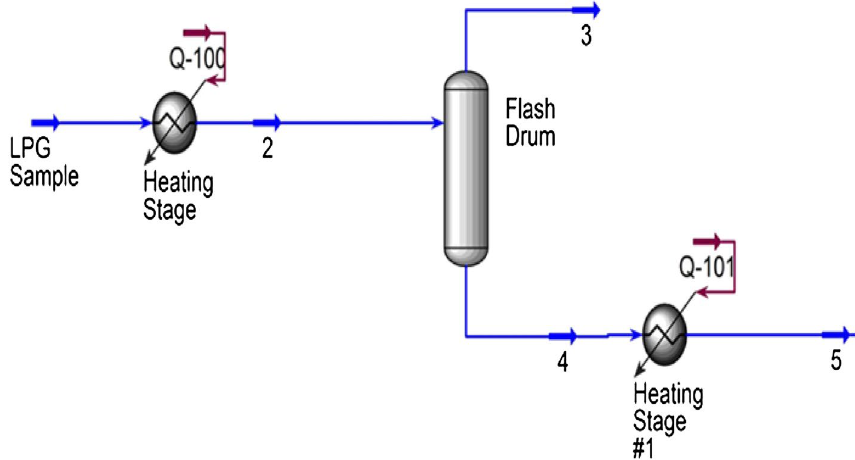
Fig. 2 Steady-state model for weathering of